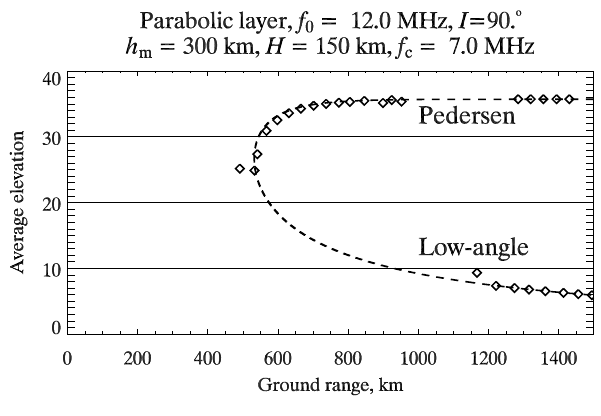
Fig. 3. Effective elevation angle vs. range for the simulated data in Fig. 1 overlaid with analytical dependence (dashed line).